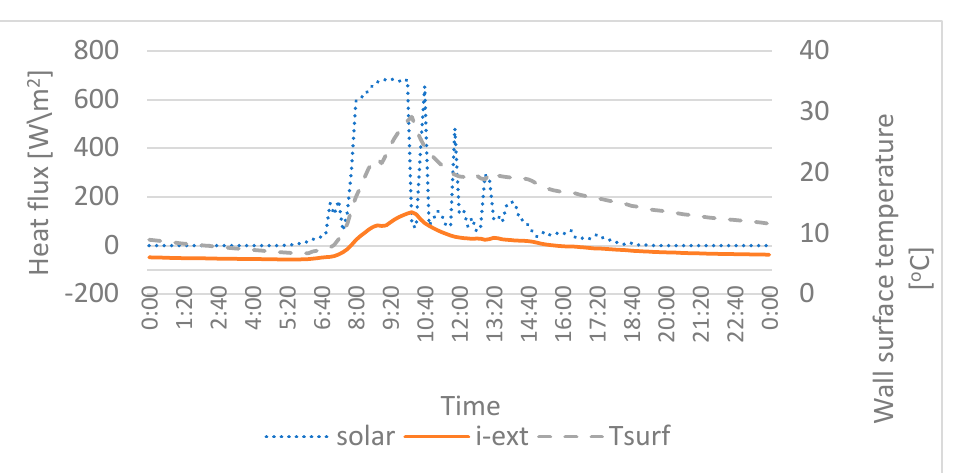
Figure 16. Solar radiation, heat flux on the ext-e surface and external wall surface temperature on 24 April 2021.